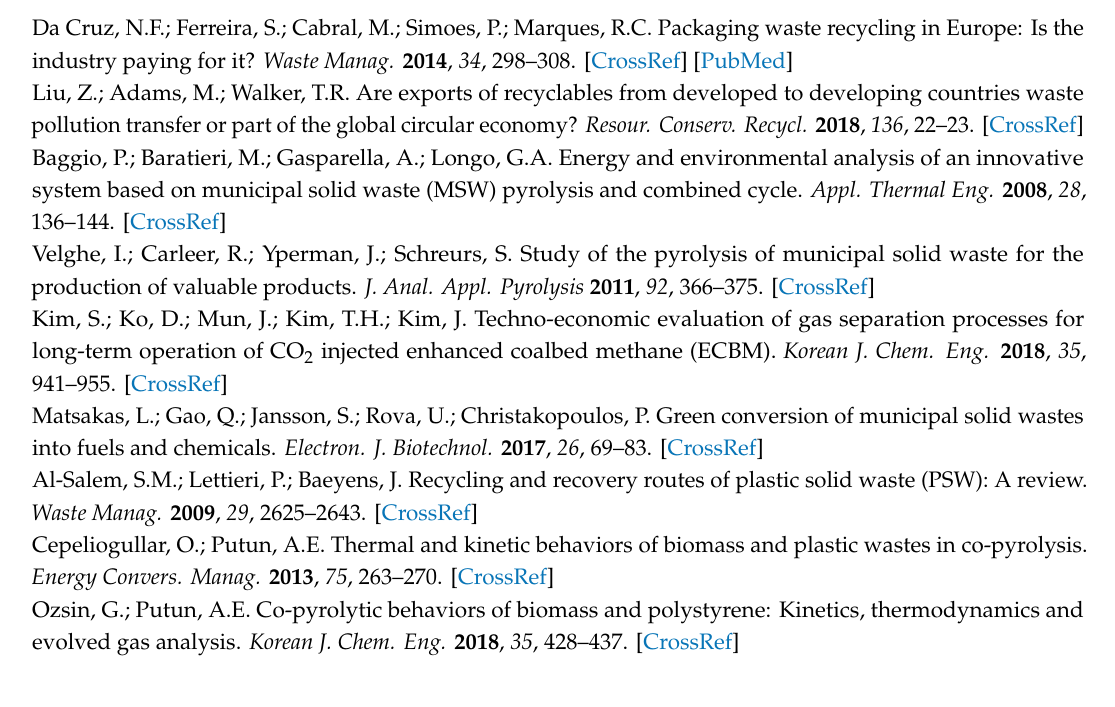
Table S1: Proximate analysis results of SPE, SKP, and SAF; Table S2: NH 3 -TPD results over acidic catalysts; Table S3: T max values ( ◦ C) of first and second decomposition stages of SKP / SPE and SKP / SPE / SAF; Table S4: T max values ( ◦ C) of each weight loss stage on the thermal and catalytic DTG curves of TP-1 and TP-2; Table S5. GC / MS peak areas for the compounds obtained from the non-catalytic TMR-GC / MS analysis of SKP, SPE, and their mixture extracted from TP-1; Table S6. GC / MS peak areas for the compounds obtained from the non-catalytic TMR-GC / MS analysis of SKP, SPE, and their mixture extracted from TP-2; Table S7. GC / MS peak areas for the compounds obtained from the catalytic pyrolysis of TP-1 and TP-2 over acidic catalysts; Table S8: TMR-GC / MS conditions applied in this study; Figure S1: NH 3 -TPD curves of HZSM-5(30), HBeta(38), and Al-MCM-41(20) used in this study; Figure S2: DTG curves of SKP / SPE mixtures (a) without SAF and (b) with SAF obtained from their TG analysis at 10 ◦ C / min; Figure S3: TICs obtained from non-catalytic TMR-GC / MS analysis of SKP, SPE, and their mixture extracted from TP-1 at 650 ◦ C; Figure S4: TICs obtained from non-catalytic TMR-GC / MS analysis of SKP, SPE, and their mixture extracted from TP-2 at 650 ◦ C; Figure S5: TIC obtained from the catalytic pyrolysis of TP-1 and TP-2 over di ff erent catalysts at 650 ◦ C; Figure S6: SAF, SKP, and SPE separated from TP-1 by solvent separation; Figure S7: SAF, SKP, and SPE separated from TP-2 by solvent